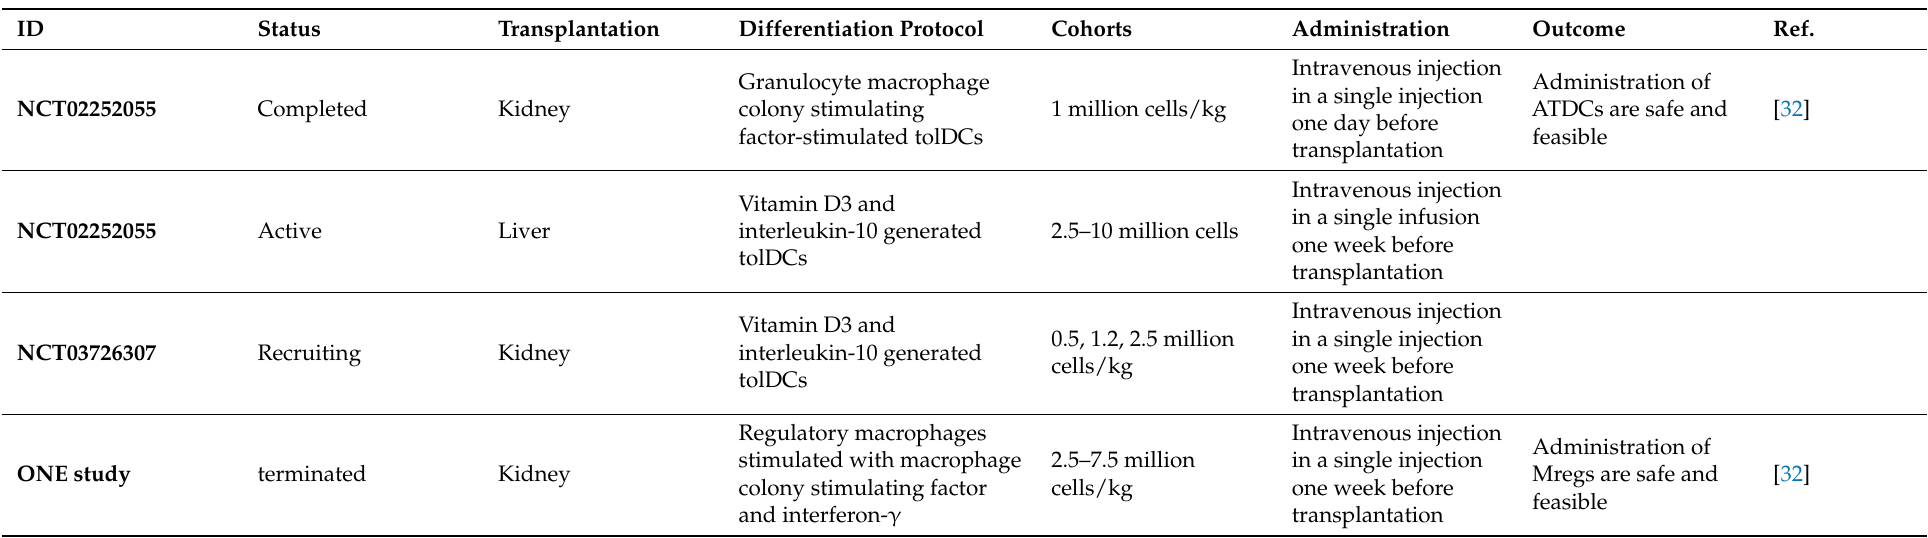
Table 2. Completed and ongoing clinical trials using tolDC and Mregs in